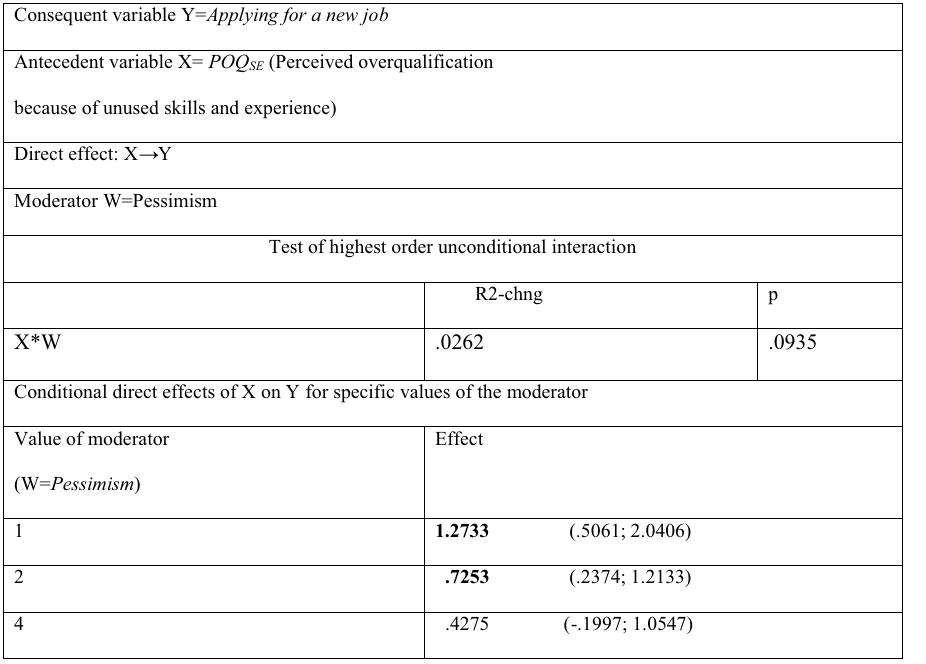
Number of participants: N